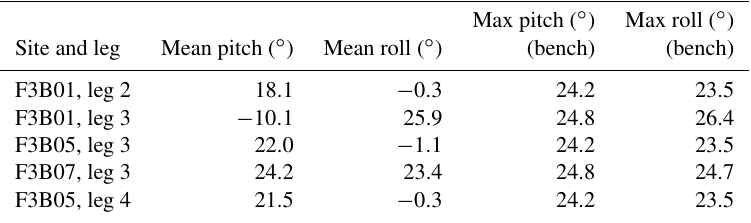
Table 3. Severely tilted time series